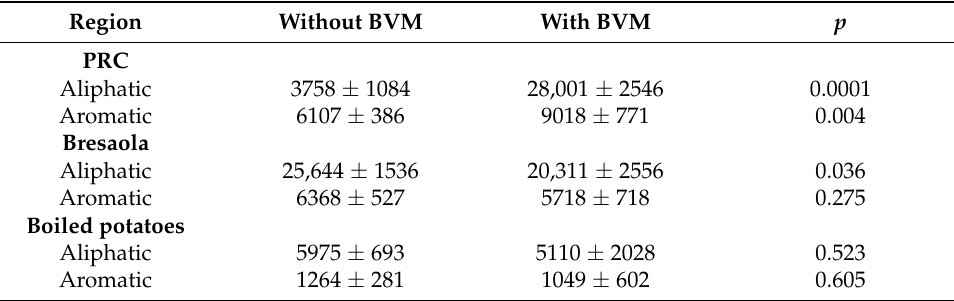
Figure 4. Integral area of aliphatic and aromatic region of in vitro digested samples of PRC, Bresaola, and boiled potatoes. All data are means ± SD of at least three independent in vitro digestions. In each food matrix and spectral region, statistical analysis was by the one-way ANOVA with Tukey’s post hoc test to compare the release of soluble molecules at different time points (different letters indicate significant differences) and by the Student’s t -test to evaluate the effect of BVM at each time point (* at least p < 0.05). Table 4. Differential integral area ( ∆ 4D–1G) of aliphatic and aromatic region of in vitro digested PRC, Bresaola, and boiled potatoes. All data are means ± SD of at least three independent in vitro digestions. Statistical analysis was by Student’s t